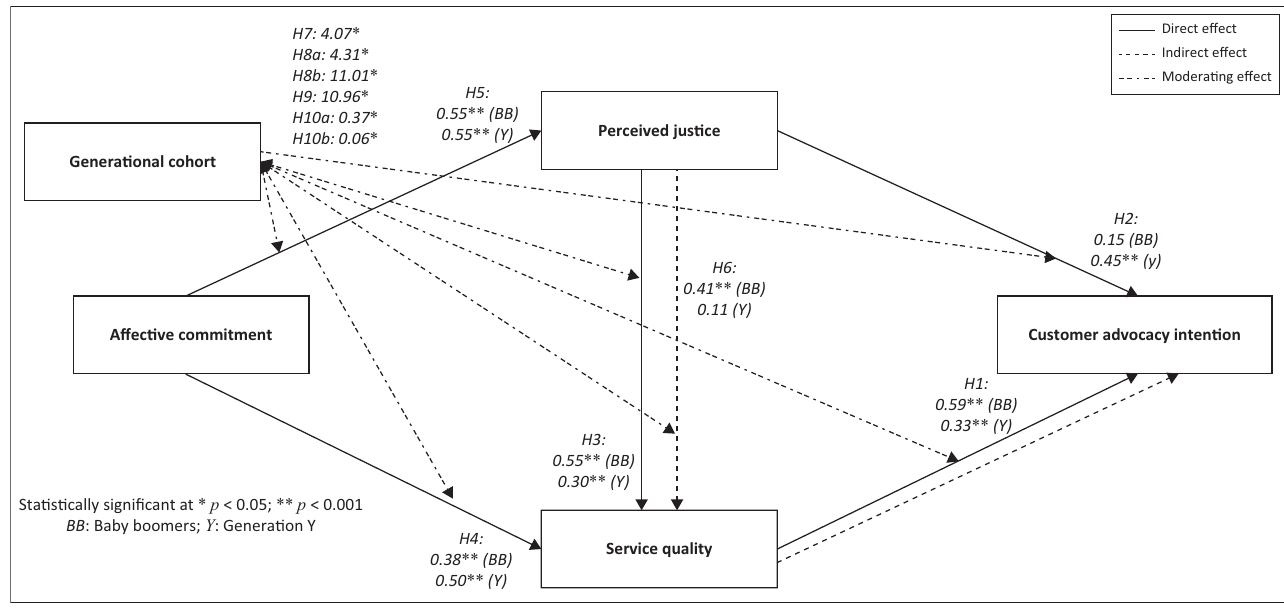
FIGURE 2: Structural